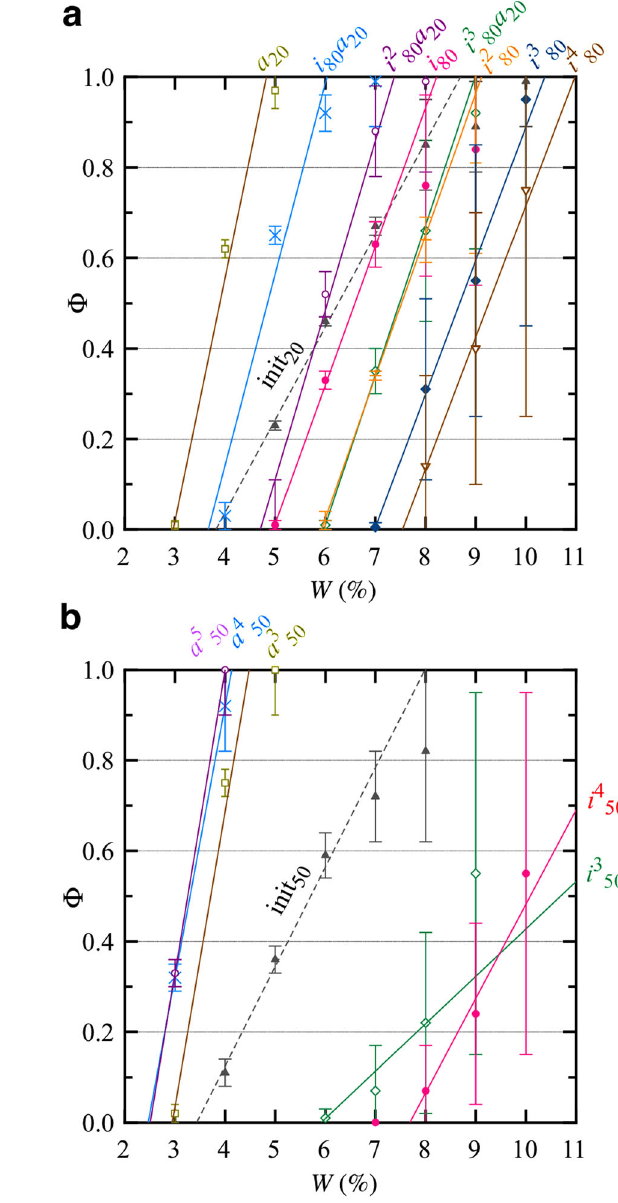
Fig. 2 The effect of fractionation on cholesteric – isotropic coexistence. Phase separation diagrams showing the volume fraction Φ of cholesteric (anisotropic) phase as a function of global sample CNC mass concentration W for each fraction of the 20/80 scheme ( a ) and the 50/50 scheme ( b ), respectively. Errors are dominated by the diverging time for phase separation as the CNC concentration approaches the threshold for kinetic arrest. Error bars are careful estimates of the resulting read-out errors, as detailed in Supplementary Note